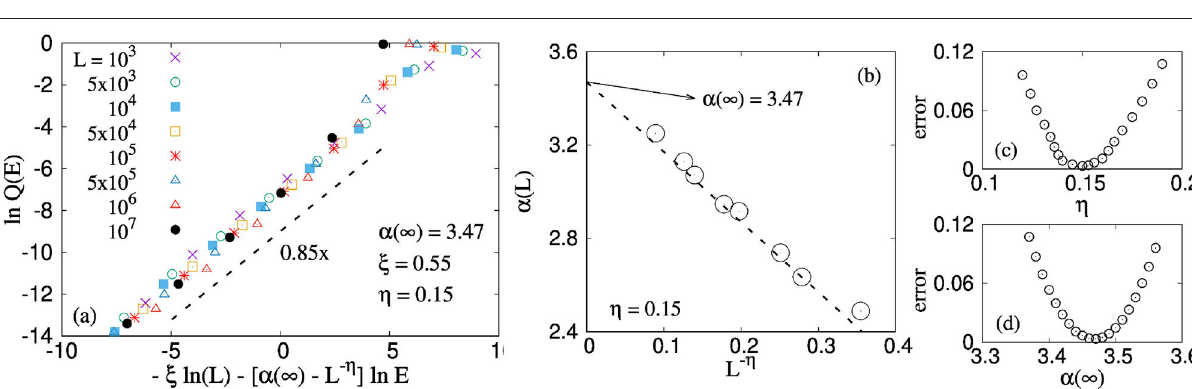
Frontiers in Physics |